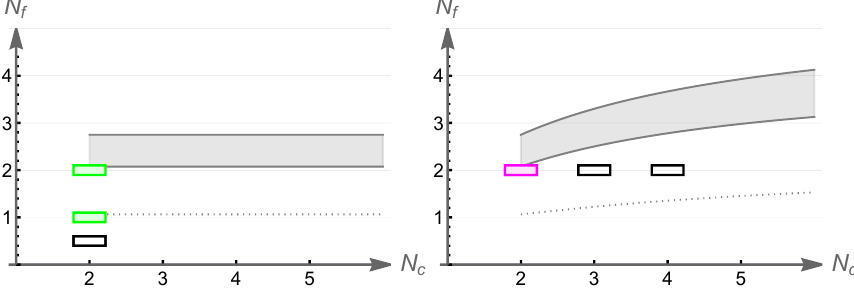
Figure 5. Summary of results for SU( N c ) gauge theory and fermions in the adjoint representation ( left panel) or two-index symmetric representation ( right panel). The rectangles depict existing lattice result for different calues of N c and N f . The colored rectangles indicate an observation of an IRFP; see text for more